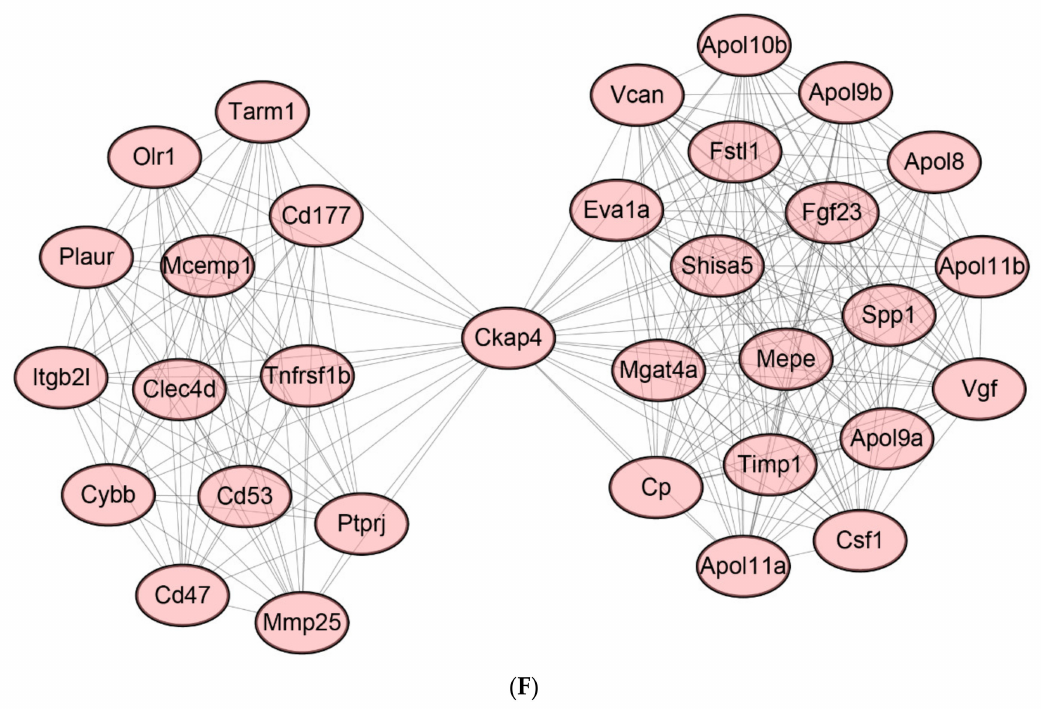
Figure 9. The protein–protein interaction analysis of DEGs by using the MCODE plugin of Cytoscape. ( A – C ) Protein–protein interaction networks of down-regulated DEGs in group 1 (LPS vs. Control). ( D – F ) Protein–protein interaction networks of up-regulated DEGs in group 1 (LPS vs.